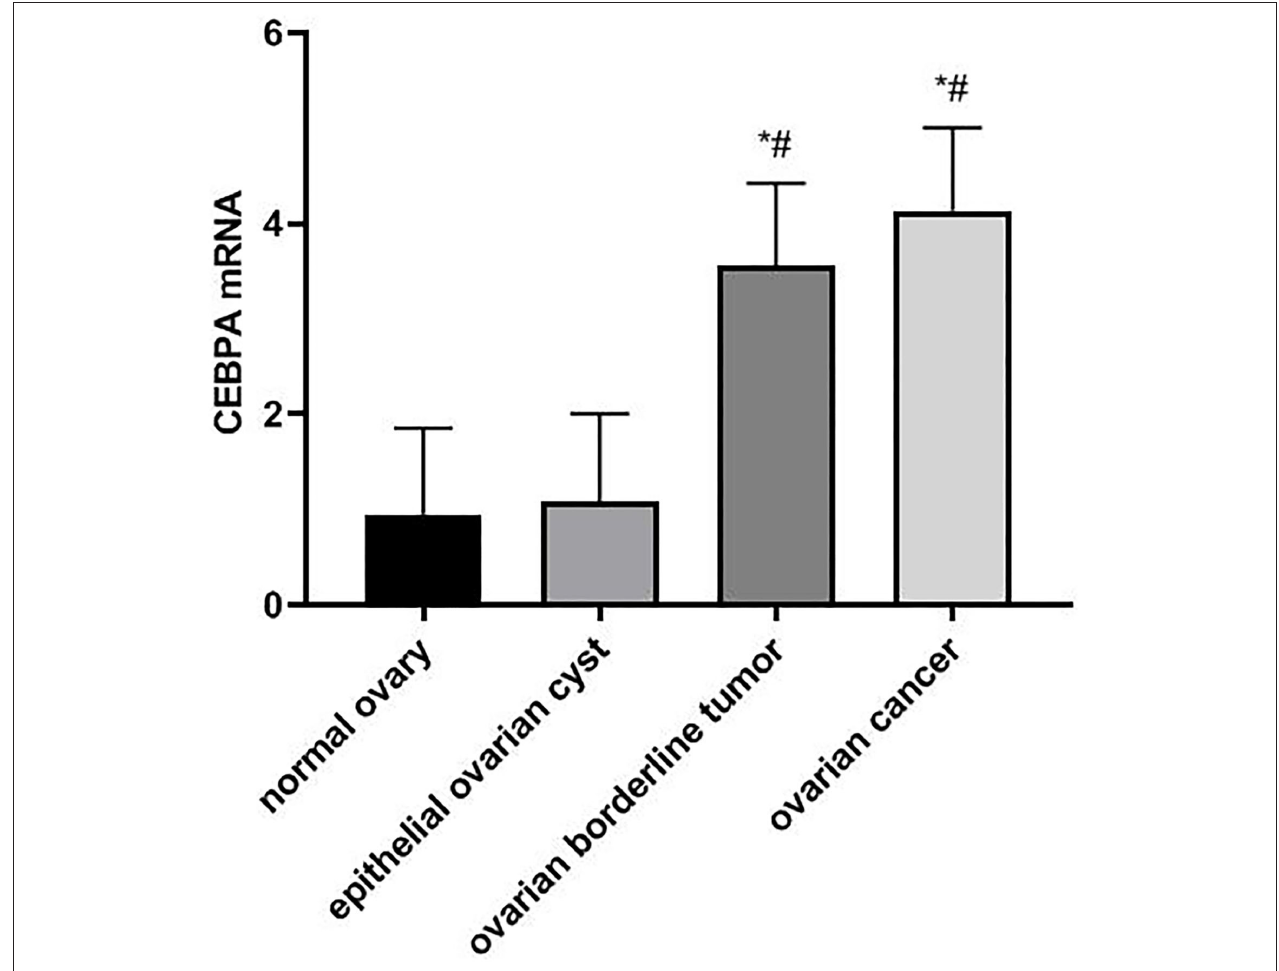
FIGURE 1 | Comparison of CEBPA mRNA expression in ovarian tissues of four groups of patients. Compared with normal ovary, * p < 0.05; Compared with an epithelial ovarian cyst, # p < 0.05. CEBPA, CCAAT enhancer-binding protein